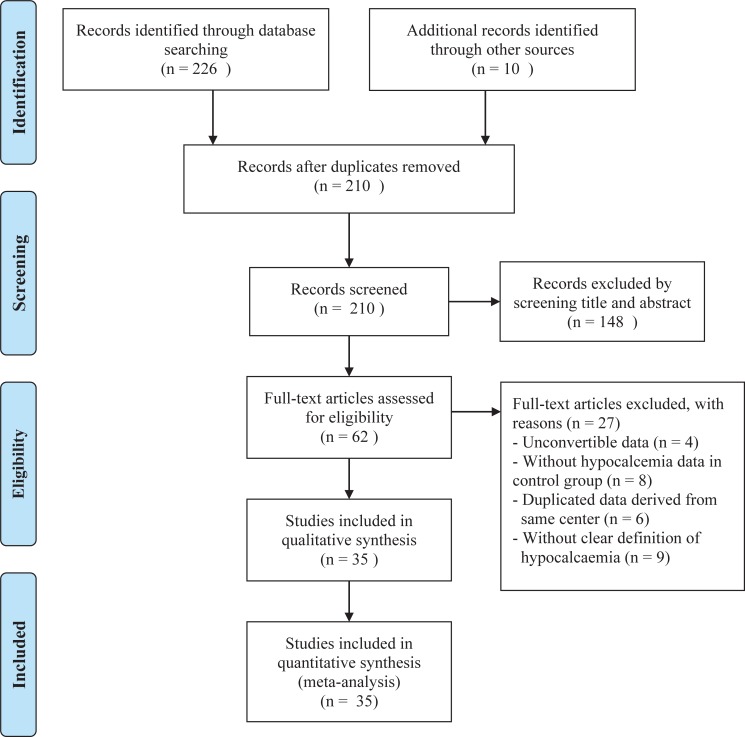
Flow diagram of the study selection.Two authors (BL Bai and WZ Chen) participated separately in the entire study selection process. We identified papers through a database search, and duplicate papers were identified based on title, author and abstract. There was no disagreement at this step. For screening and eligibility, some disagreement occurred, with Kappa values of 0.8922 and 0.8256.